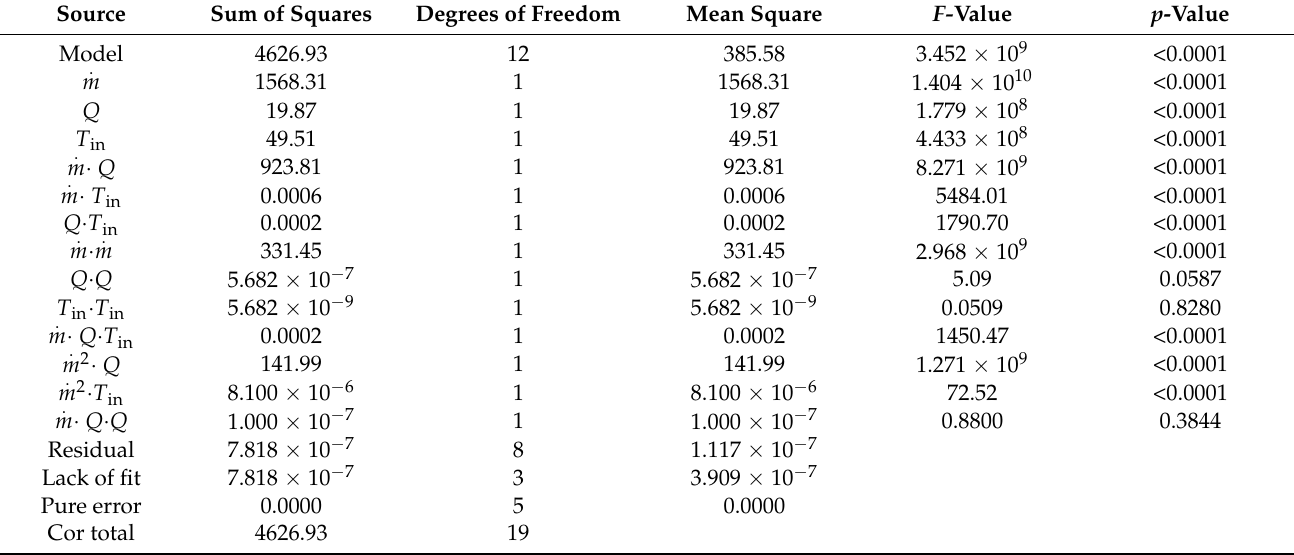
Table 4. The ANOVA for the average temperature (before elimination).